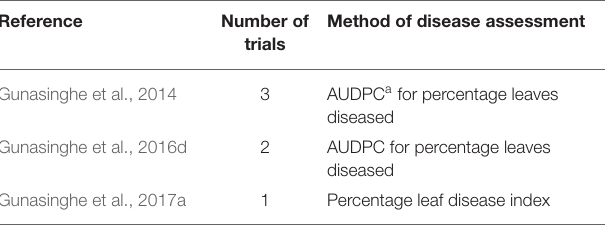
TABLE 2 | Details of six field trials conducted in Western Australia, used to extract data for meta-analysis to identify susceptibility differences among three common Brassica species to Neopseudocercosporella capsellae